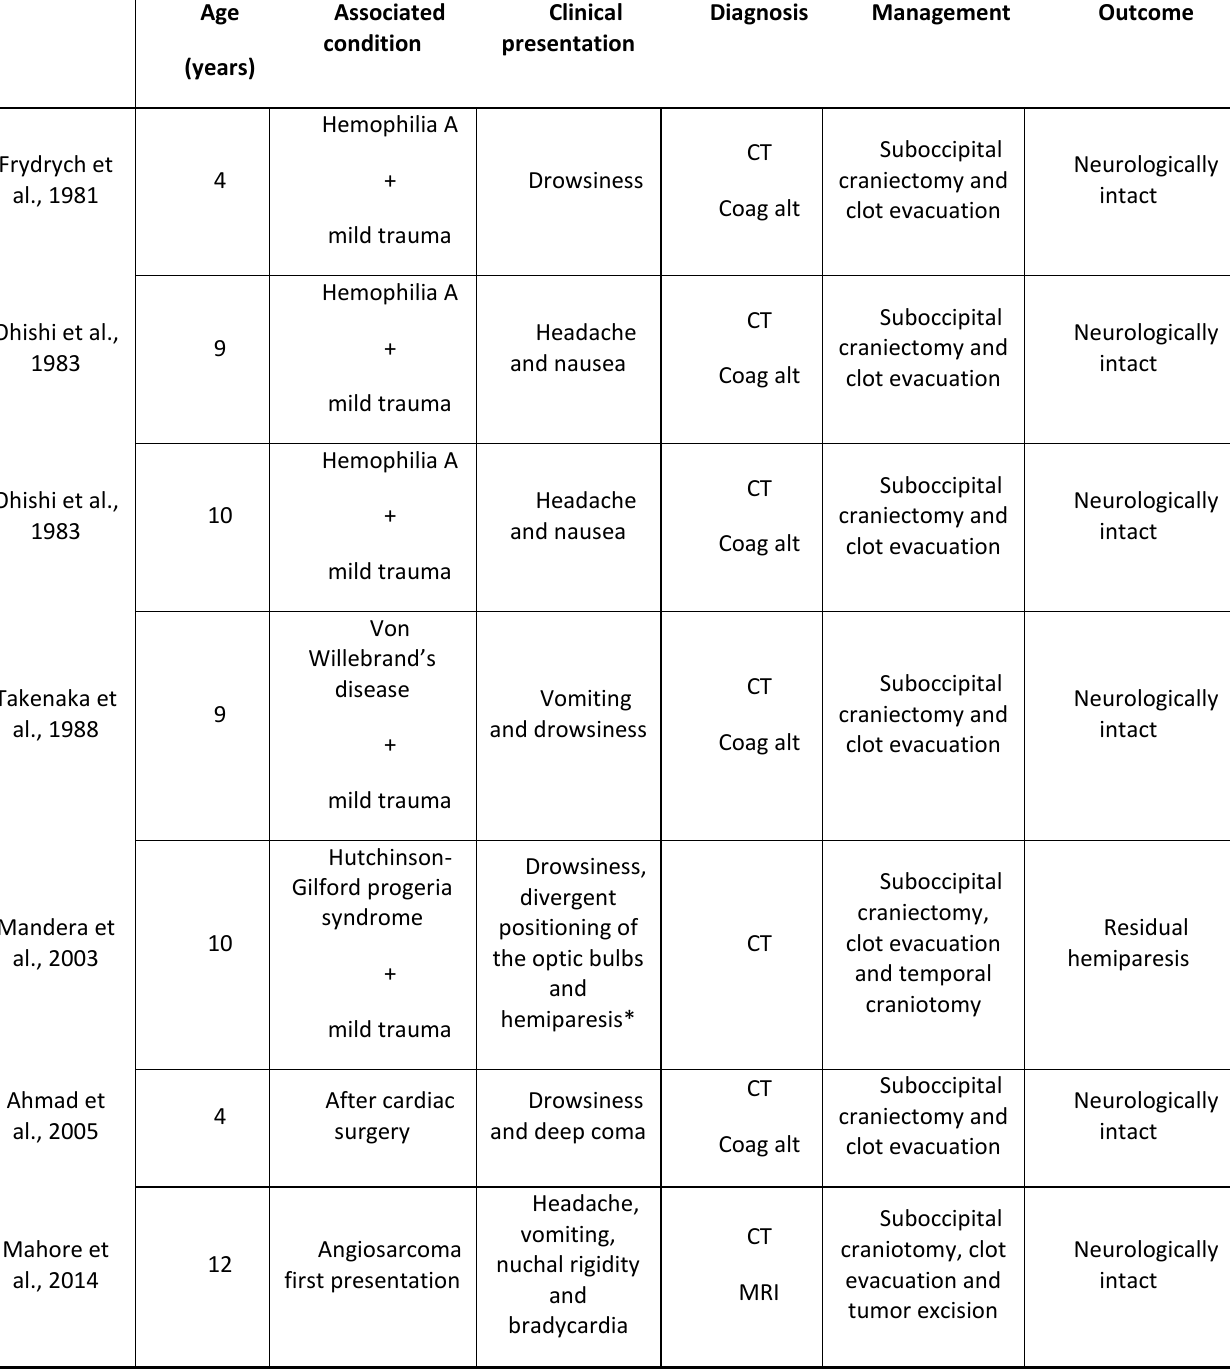
Table 1. Detailed description of the mentioned cases of posterior fossa extradural hematoma in